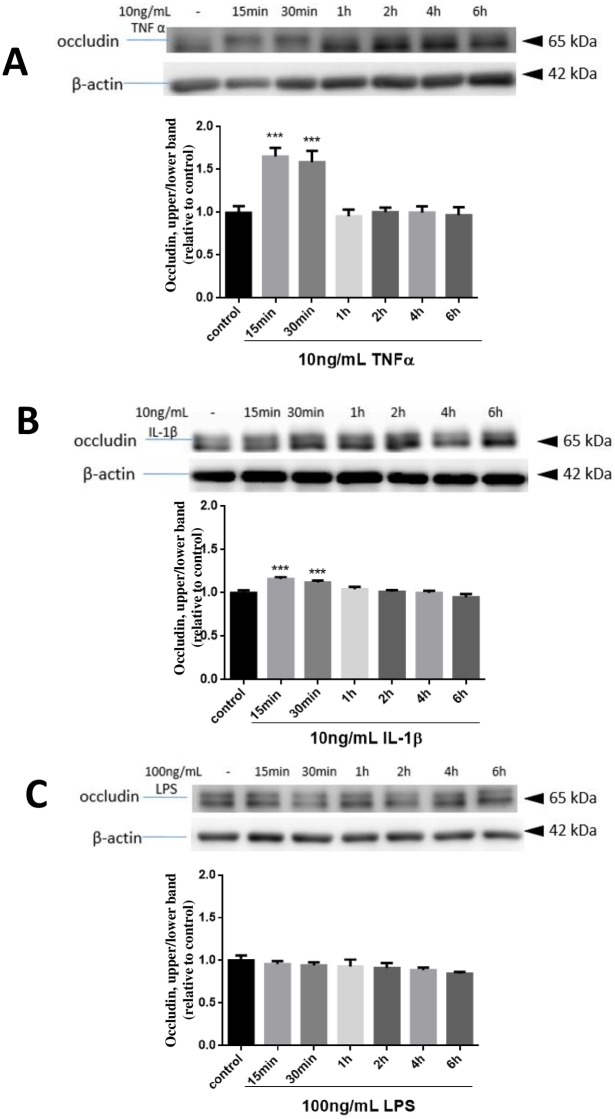
Effects of TNFα, IL-1β and LPS on occludin band-shift in hCMEC/D3 cells.Cells were treated with or without TNFα (10 ng/mL) (A), IL-1β (10 ng/mL)(B) and LPS (100 ng/mL) (C) for 15, 30 min and 1, 2, 4, 6 hours. Cell lysates were collected and occludin and β-actin expression patterns were analyzed by immunoblotting assay as described in text. The density of upper band versus total upper and lower and normalized with β-actin was determined by measuring protein intensity as PIupper/PItotal/PIβ-actin. Results are mean ± SD from 4 or more experiments and data are analyzed by one-way ANOVA followed by Bonferroni post-tests (***P<0.001 compared with no treatment control).